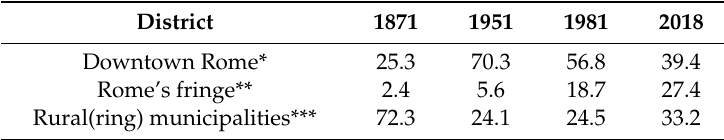
Table 1. Percent share of resident population in total population of the Rome’s metropolitan area by urban